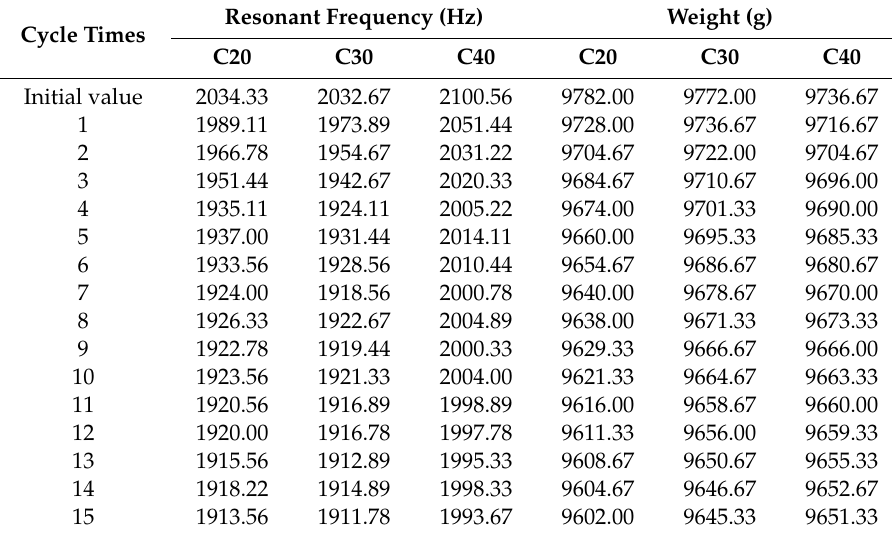
Table 4. Resonant frequency and weight change of concrete